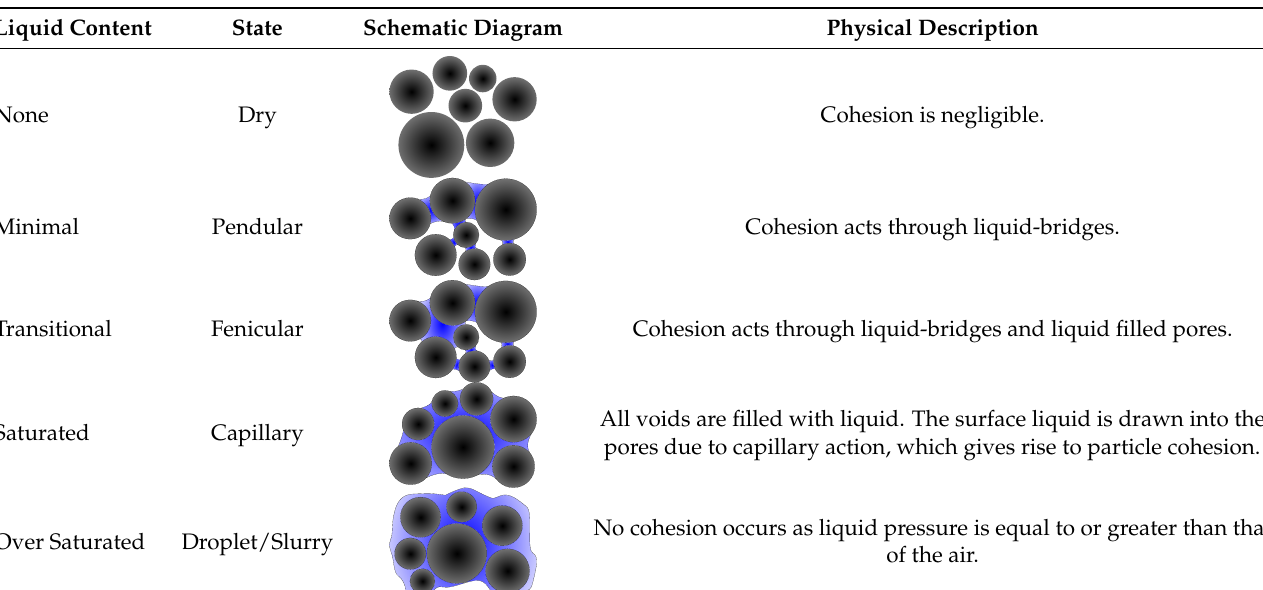
Table 1. States of saturation